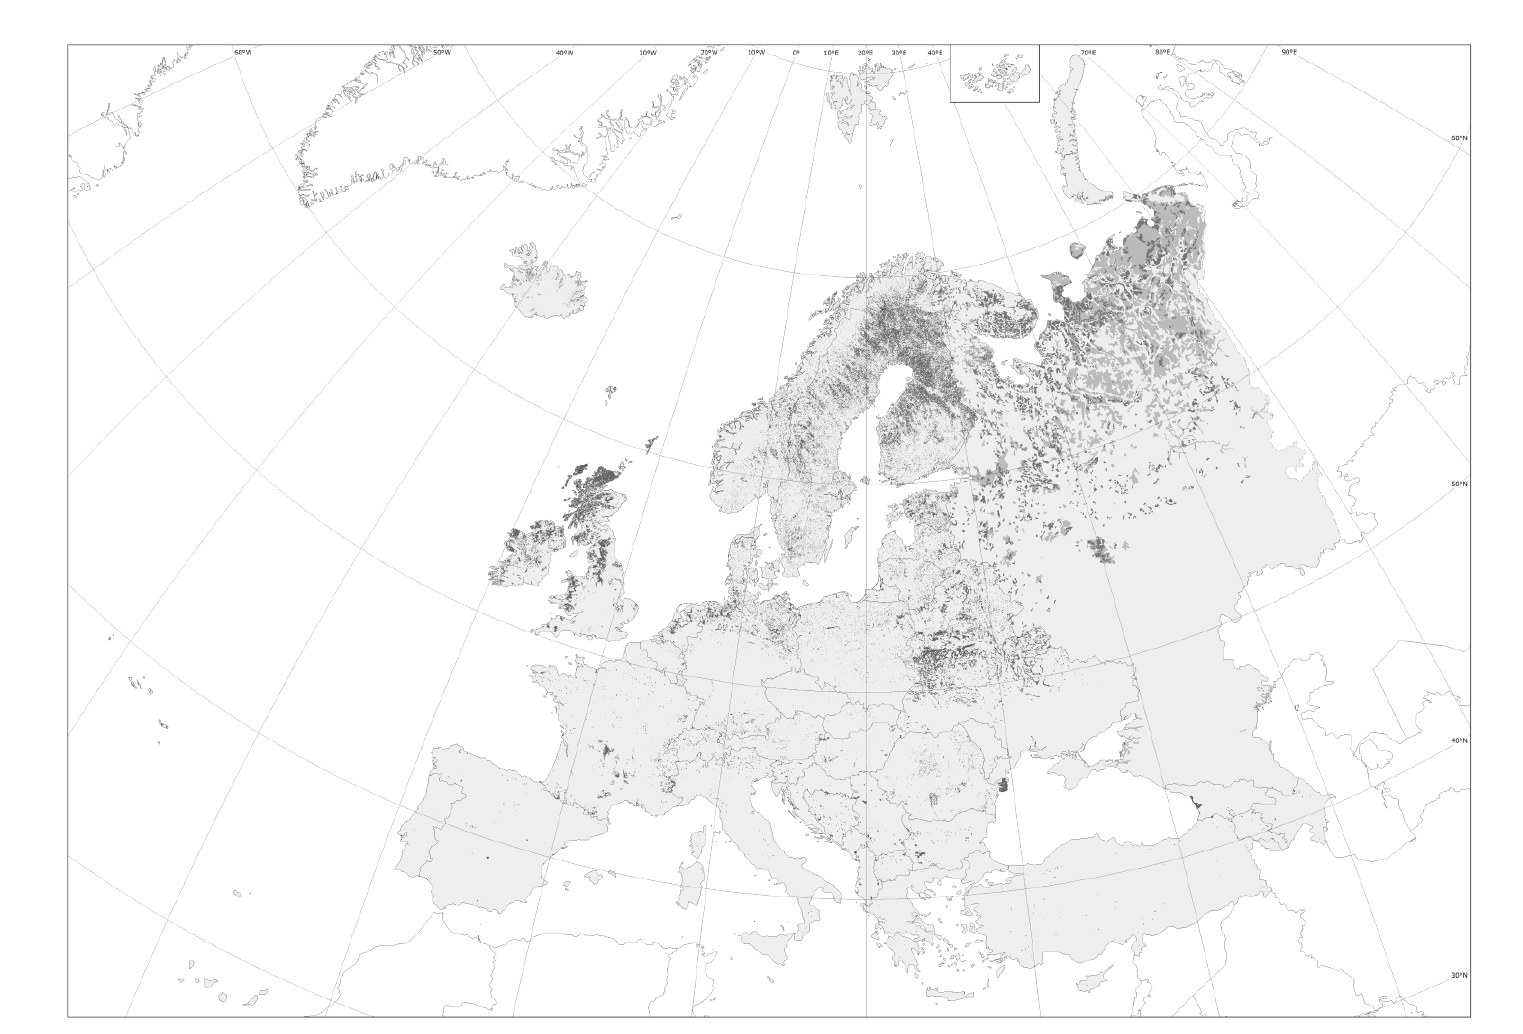
Figure 1. The composite peatland map of Europe, showing the distribution of peatland/organic soils derived from best-available national datasets. Note that small and sparsely distributed peatlands in (mostly) southern European countries are slightly enlarged for better visibility, and that the paler shading in European Russia represents peat < 30 cm thick. See text for further